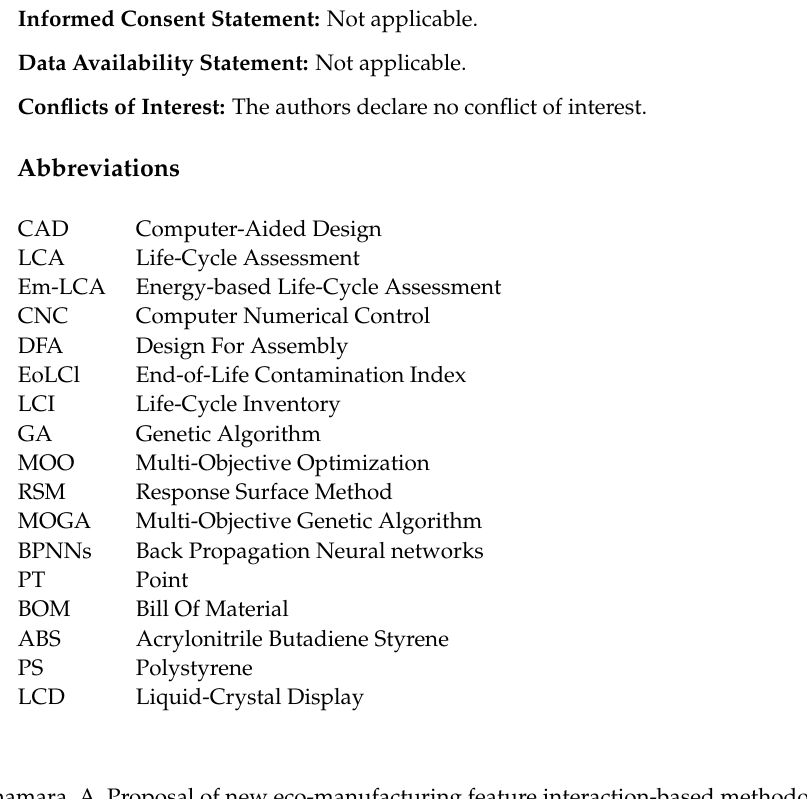
model; Table S13: The error rate of the training and validation set for the first-order model with interaction; Table S14: The error rate of the training and validation set for the second-order